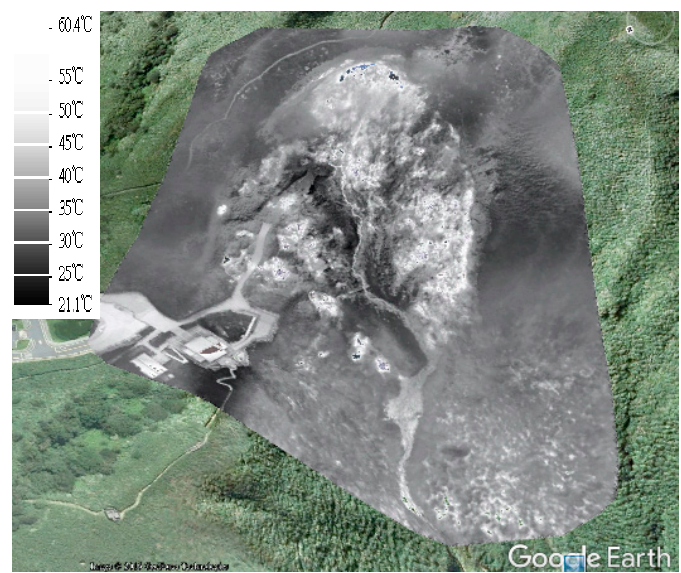
Figure 14. The overlay of thermal orthoimage and Google Earth.